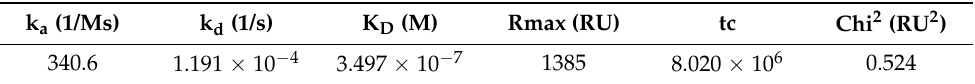
Figure 3. Detection range of the antibody and antigen reaction showing a good linear relationship. Consequently, the ELISA analysis that followed had adopted an antibody concentration at 125 µ g/mL. Table 1. Kinetic analysis of immobilized of E6 protein and anti-HP-1 IgY antibodies with different